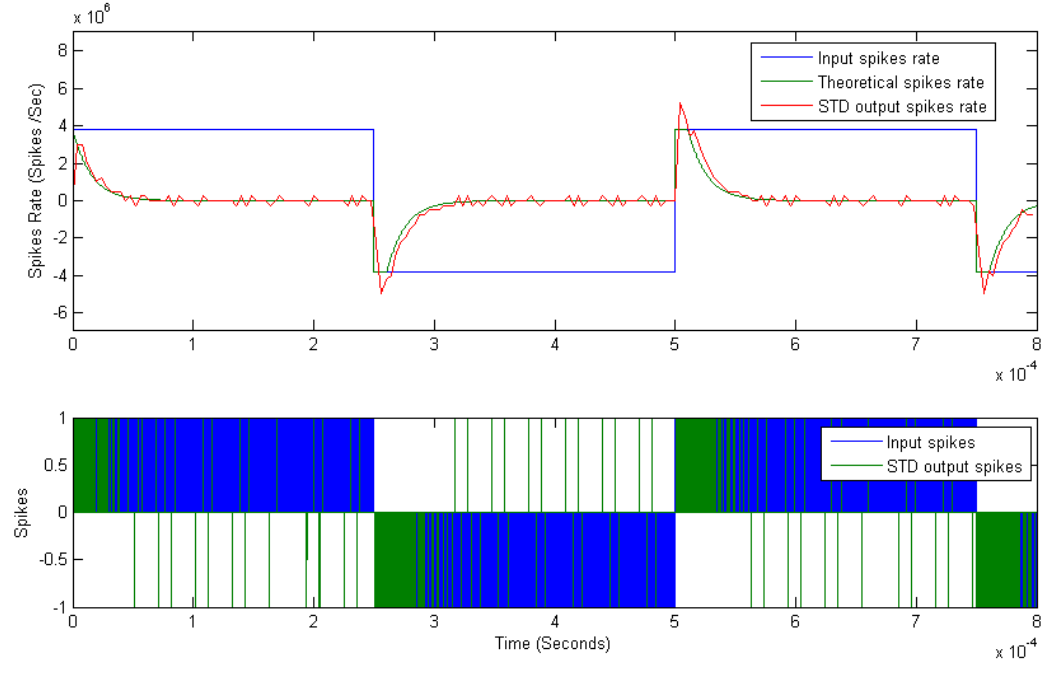
Figure 13. Spikes Temporal Derivative